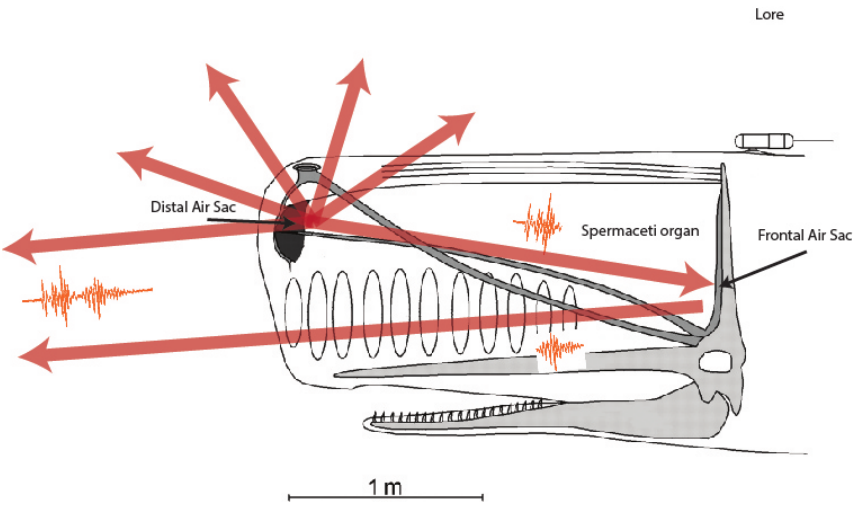
Figure 1. Sperm whale emission principle: a pulse is emitted by the distal air sac, propagated by the spermaceti organ and reflected by the frontal air sac.